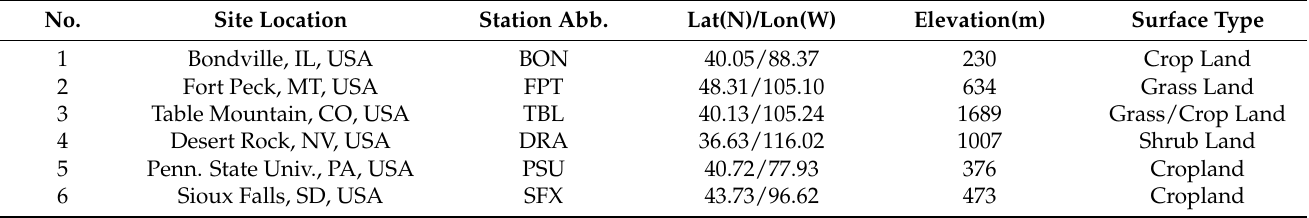
Table 1. Geo-Location and surface type of the six SURFRAD